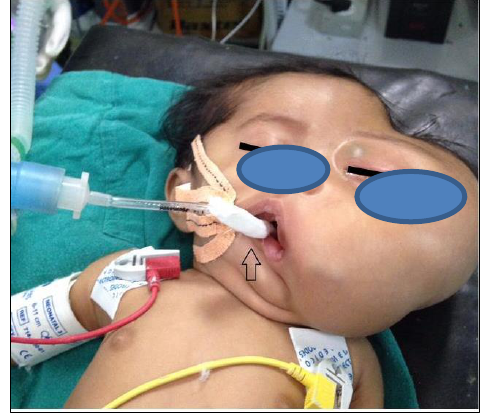
Figure1 showing the teratoma of face and scalp Inside the operation theatre, all ASA standard moni- tors were attached and child was premeditated with intravenous injection of midazolam 0.3mg. Supports were placed on the sides of swelling to keep the face in central position. The child was pre-oxygenated with face mask placed upside down to provide a good seal and perform effective ventilation. Anesthesia was induced with sevoflurane in 100 % oxygen. After induction, a shoulder block was placed and head was held in air to achieve adequate neck extension. Miller laryngoscope was introduced using the right molar approach. The glottis was visualized, but the endotracheal tube (ETT) could not be negotiated. A left lateral head rotation was given to align the lar- yngeal axis with oral axis and airway was secured using 3.5 ETT. After confirmation of ETT placement, injection atracurium was given. Anesthesia was maintained with nitrous oxide with oxygen and sevoflurane. Surgery lasted for two hours and blood loss was 100 ml, which was suitably replaced. After completion of surgery, neuromuscular blockade was reversed and trachea extubated. Rest of the hospital stay was uneventful and child was discharged on post-operative day